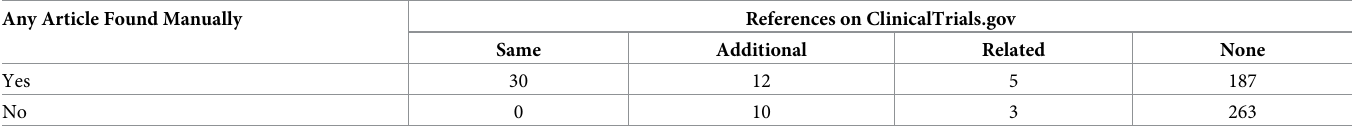
Table 8. Number of studies for which articles could be found manually and a comparison of those articles to the references found on ClinicalTrials.gov, also as num- ber of studies. Any Article Found Manually